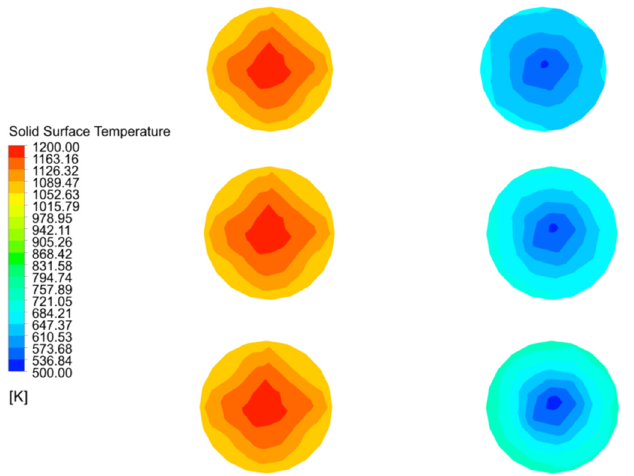
Figure 14. Distribution and variation of solid surface temperatures in double chambers on Plane 3.